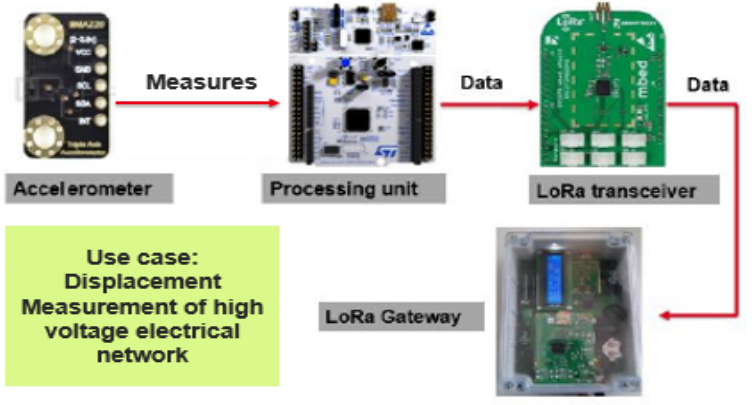
Figure 7. Hardware of the sensor node.